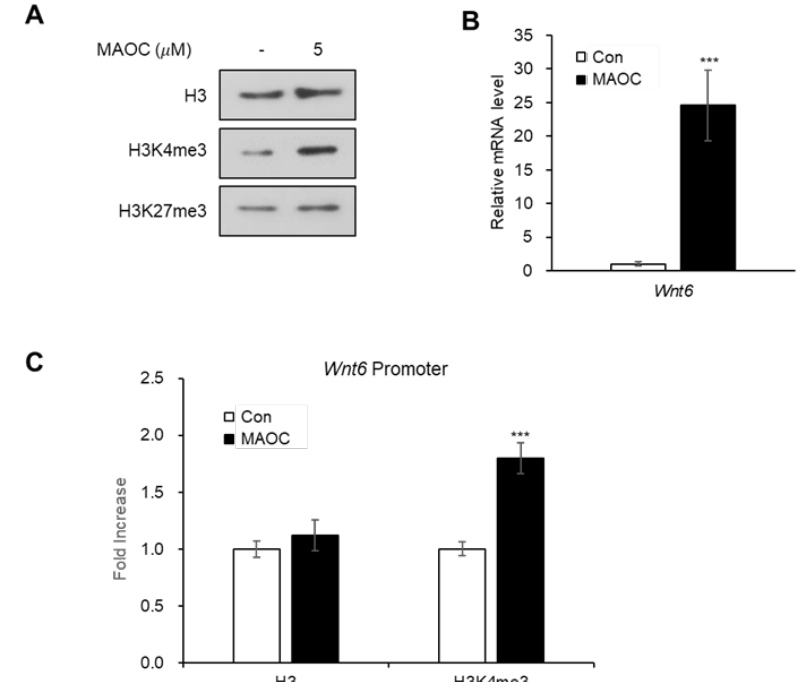
Figure 4. Treatment with morolic acid 3- O -caffeate (MAOC) increases Wnt6 expression by enhancing H3K4me3 enrichment on promoter. ( A ) Western blot analysis of 3T3-L1 adipocytes incubated with MAOC (5 μM) during adipogenesis. ( B ) The mRNA levels of Wnt6 gene in 3T3-L1 adipocytes incubated with MAOC (5 μM) during adipogenesis. Data present the means ± SEM for n = 3. *** p < 0.001. ( C ) 3T3-L1 cells were treated with MAOC (5 μM) for 24 h. ChIP assay was performed with H3 and H3K4me3 antibodies followed by qPCR with primers for promoter region of Wnt6 gene. Data present the means ± SEM for n = 3. *** p < 0.001.